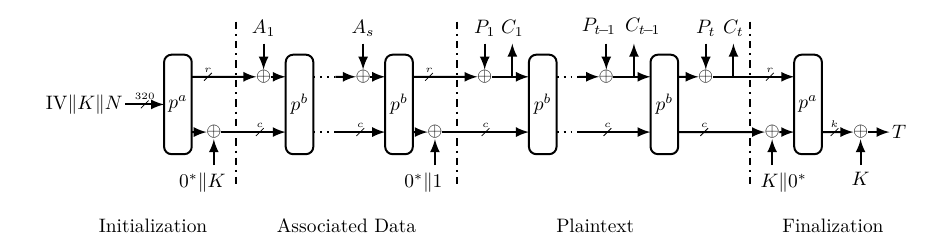
Figure 1: Encryption in Ascon